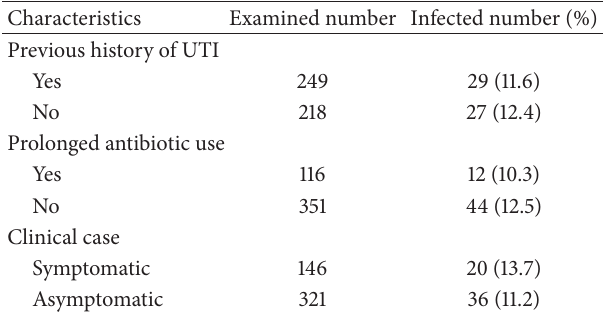
Table 3: Prevalence of UTI by associated factors among seropositive ART user and non-ART user patients, JUSH, Ethiopia, 2012.